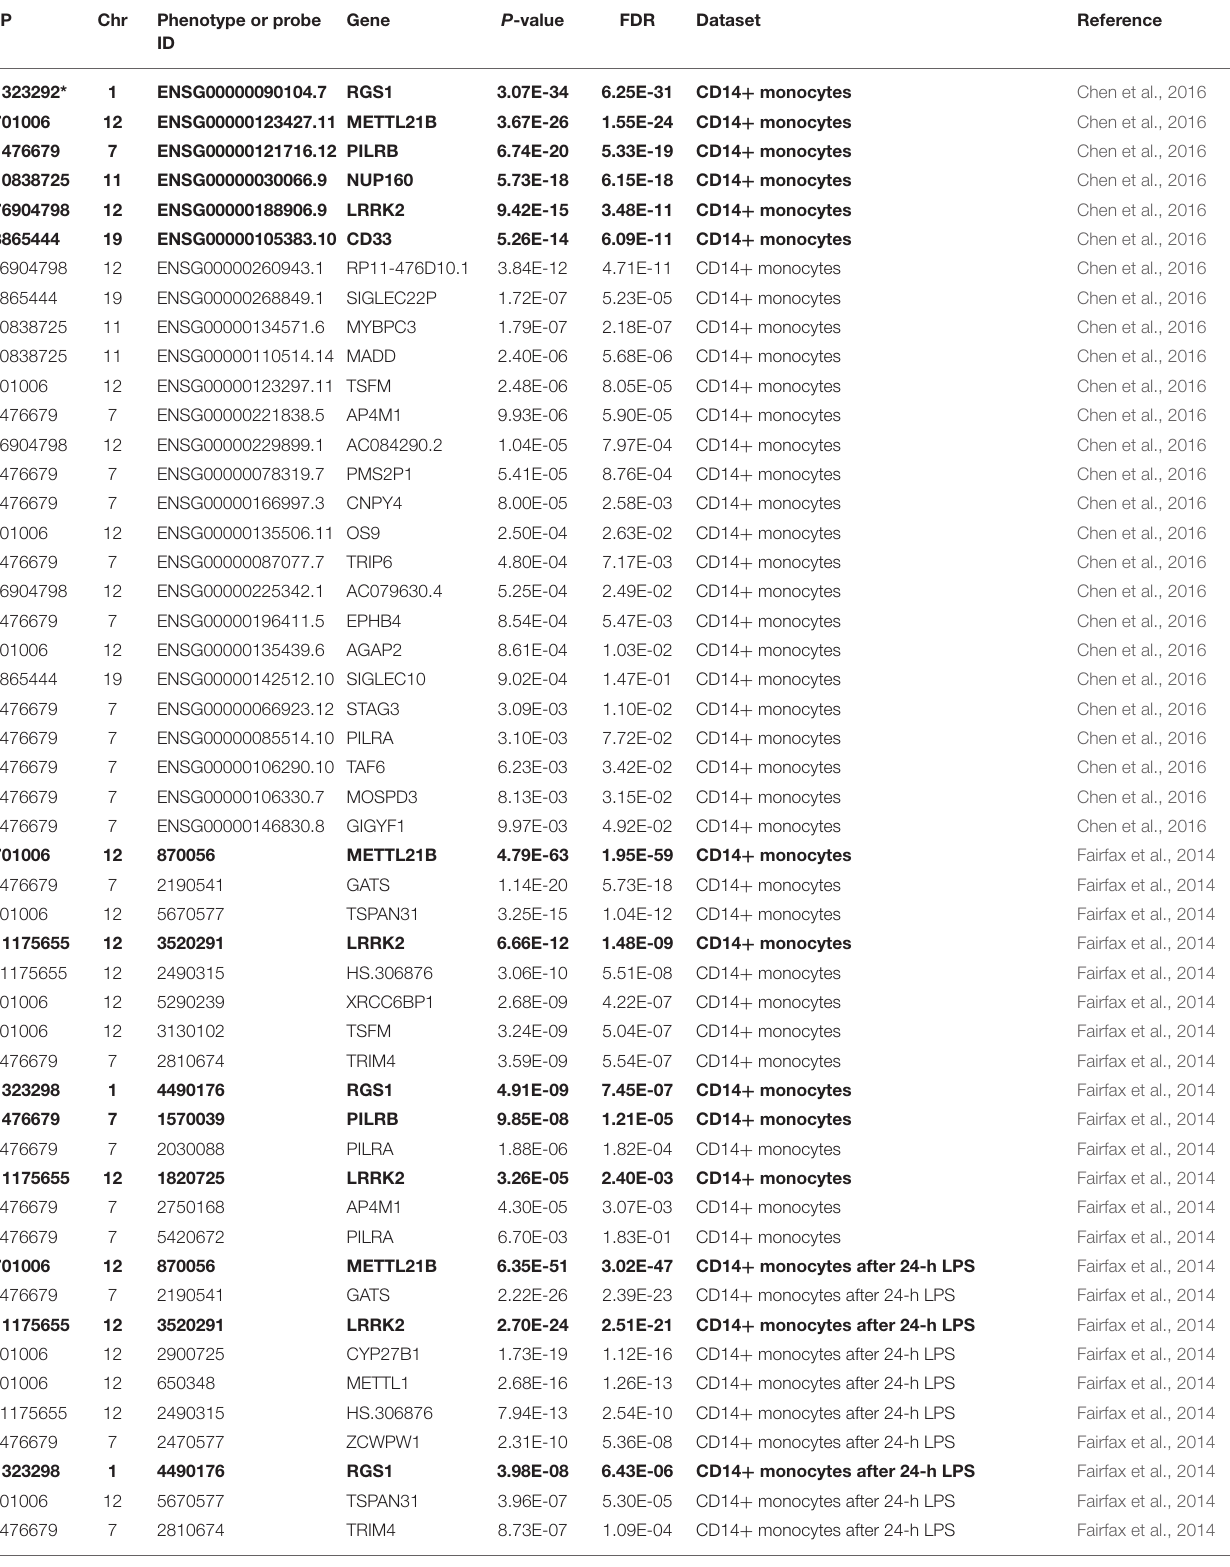
TABLE 3 | eQTL analysis of six neurodegenerative disease variants in CD14 +